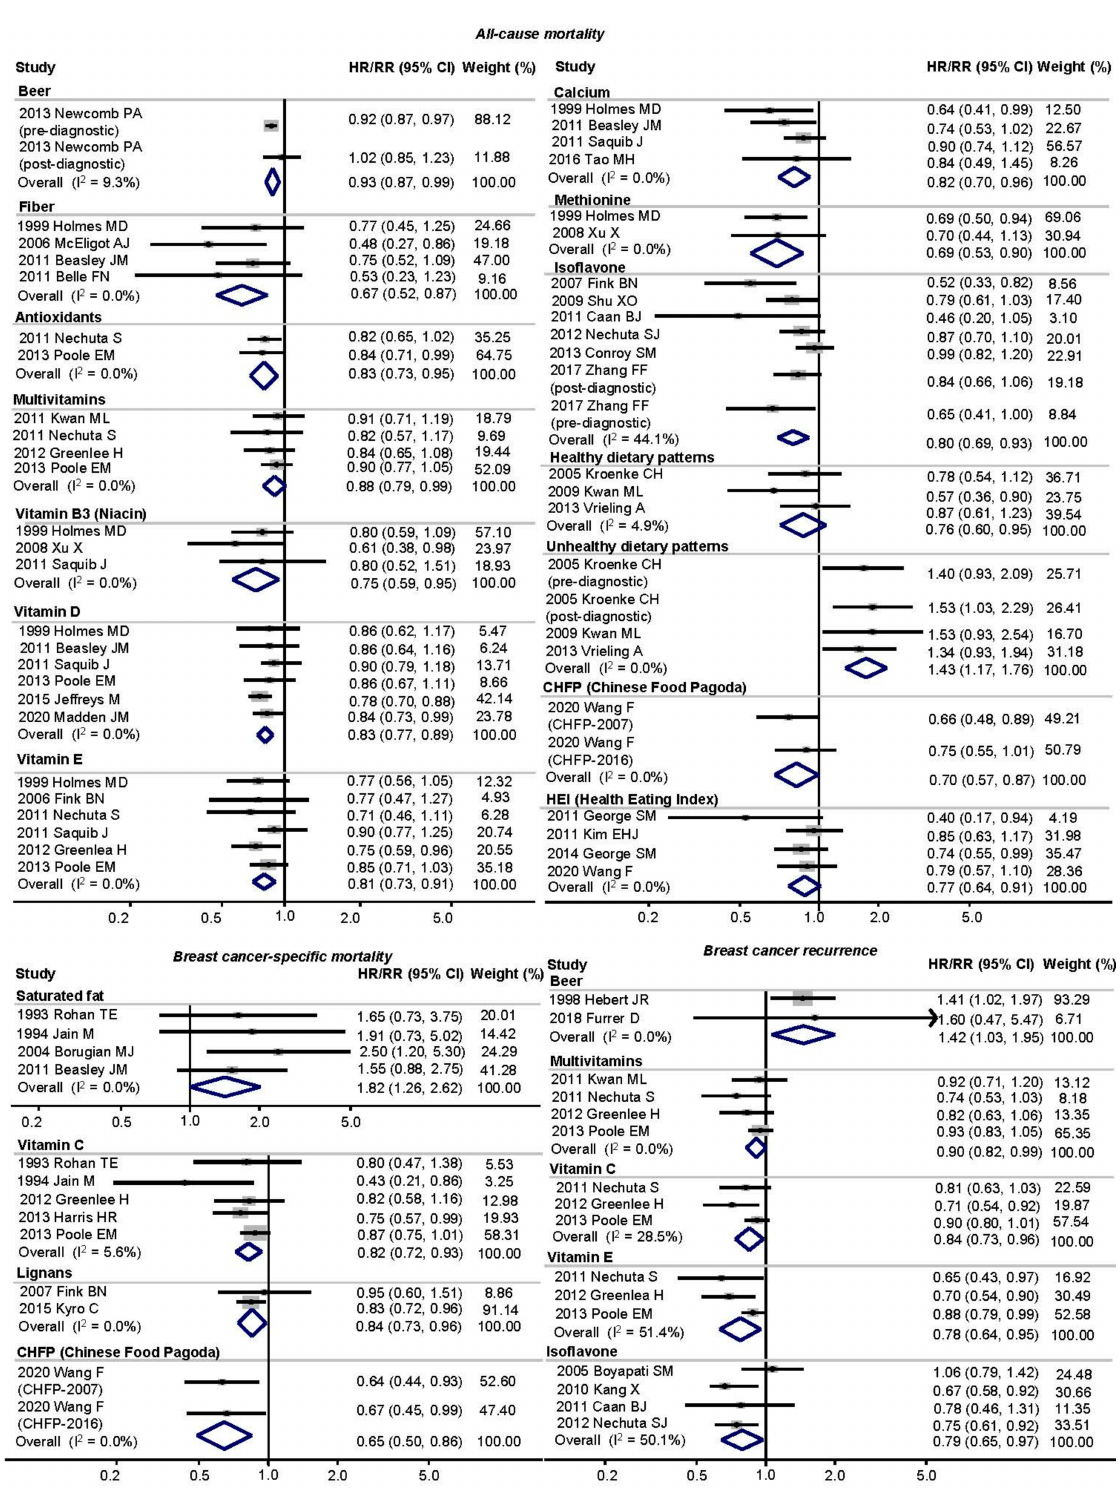
Figure 2. Forest plots for the roles of overall dietary factors and all-cause mortality among breast cancer survivors. Abbreviations: HR, hazard ratio; RR, relative risk; CI, confidence